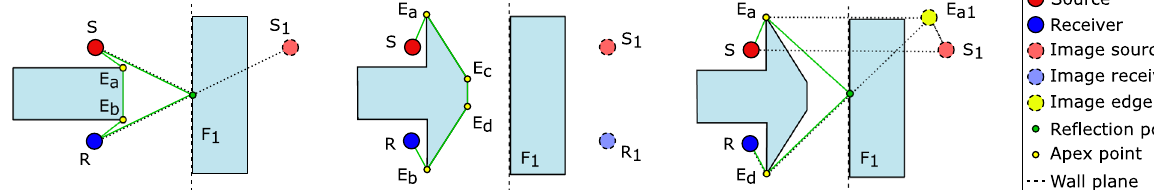
Figure 2. Comparison of the construction of propagation paths without and with image edges. (a) By use of image source S 1 , a fi rst order re fl ection path can be found. One second order diffraction path is composed of two diffractions at edges E a and E b of the left building. (b) Neither source S nor receiver R are directly illuminating the right building. Irrespective of the order of re fl ection, neither image sources nor mirrored receivers directly lead to valid re fl ection paths. (c) By introducing image edges, a valid propagation paths consisisting of re fl ections and diffractions is found.